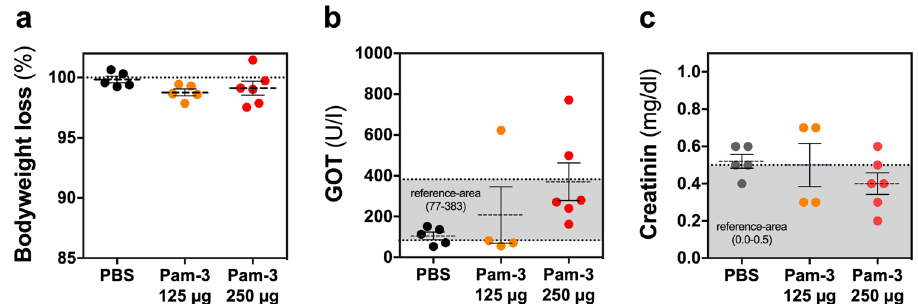
Fig. 4 Safety of orally applied Pam-3 in mice. Dose-depended oral tolerance test in mice. Animals were treated twice with 125 µ g (orange circles) or 250 µ g Pam-3 (red circles) or PBS (black circles). a Weight change of mice (125 µ g Pam-3, N = 5; 250 µ g Pam-3, N = 6 and PBS, N = 5), b glutamic oxaloacetic transaminase (GOT) levels of treated animals with 125 µ g Pam-3 ( N = 4) or 250 µ g Pam-3 ( N = 6) or PBS ( N = 5) and c creatinine levels (125 µ g Pam-3, N = 4; 250 µ g Pam-3, N = 6 and PBS, N = 5) one day after Pam-3 application. Results are presented as mean ± SEM of biologically independent animals. Table 1 Safety of orally application of Pam-3 in